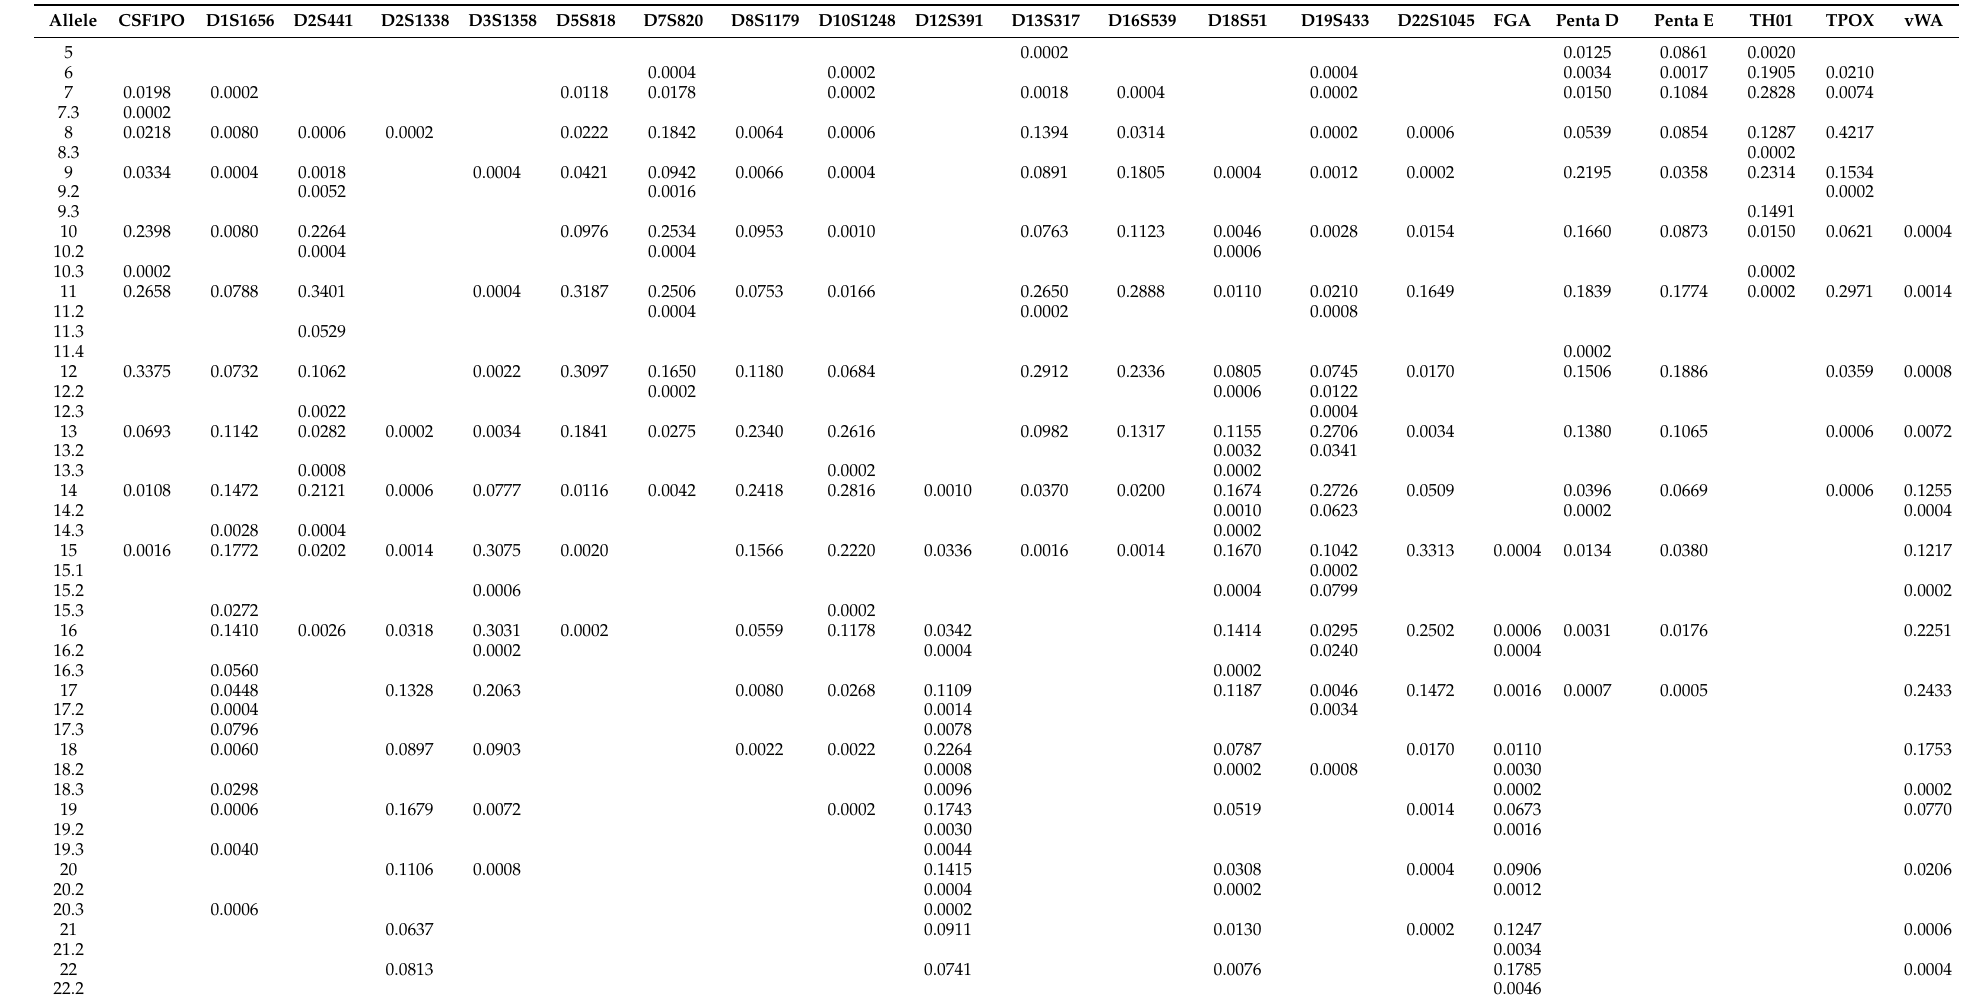
Table 2. Allelic frequencies and the forensic parameters estimated for each STR marker in the whole dataset of the 1000 Genomes